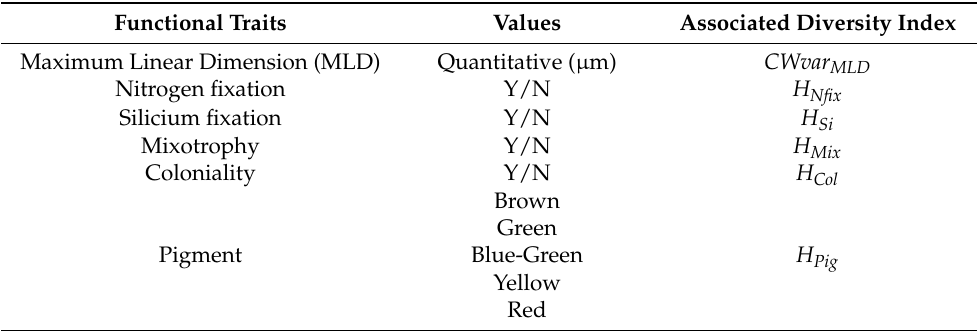
Table 1. List of the functional traits used in the study, their type and diversity index to which they are